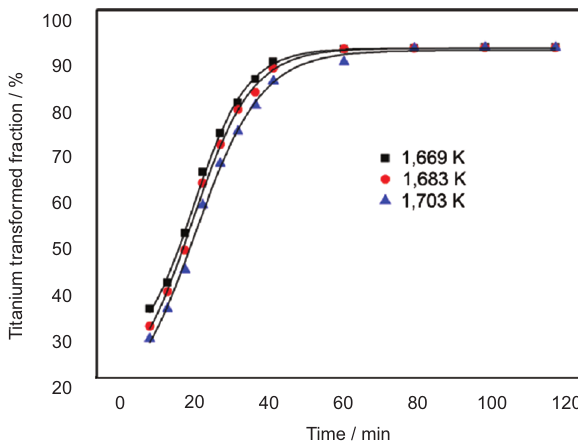
Figure 6: Relation between titanium transformed fraction ( X ) and temperature holding time ( t